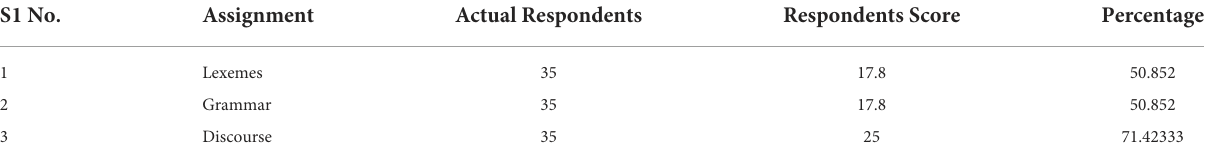
TABLE 4 Students’ scores in the linguistic and cohesive elements. S1